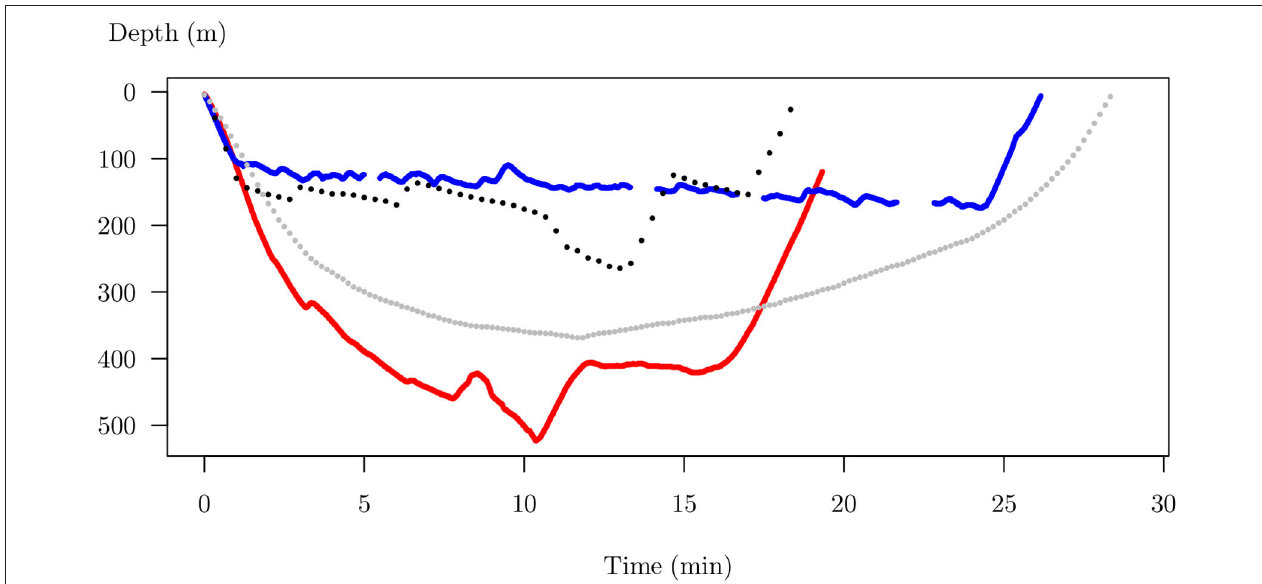
FIGURE 1 | Four dive examples from Mirounga leonina . Each dive is plotted as depth vs. time. These dives are functional data because the variable of interest (depth) is a function of time. Dives have different length in depth and time. The number and the position of the sampled points are different. Random errors can occur due to time-depth sensor problems. In this raw form, it is impossible to compare their